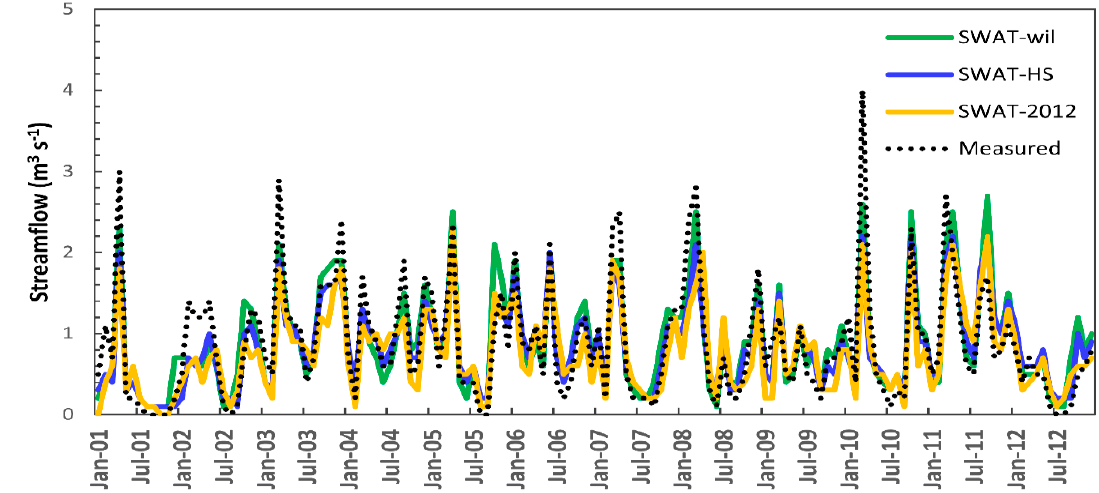
Figure 3. Comparison of monthly time series of streamflow simulated by SWAT-2012, SWAT-wil, and SWAT-HS with measured streamflow in Town Brook for the calibration and validation period 2001–2012. Table 3. Statistical evaluation of di ff erent SWAT models of Town Brook using the Nash Sutcli ff E ffi ciency (NSE) and the linear regression coe ffi cient (R 2